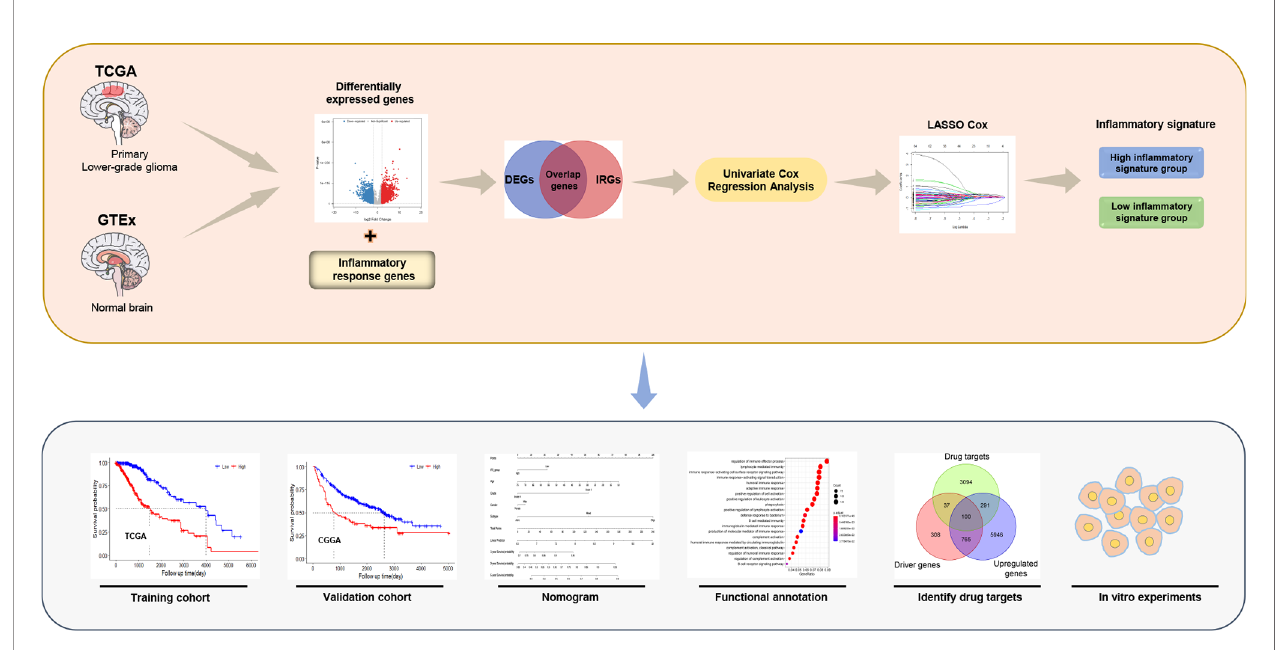
FIGURE 1 | The fl owchart of this